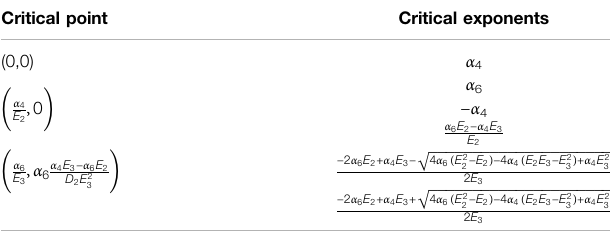
TABLE 1 | Critical points with its corresponding pair of critical exponents. Critical point Critical